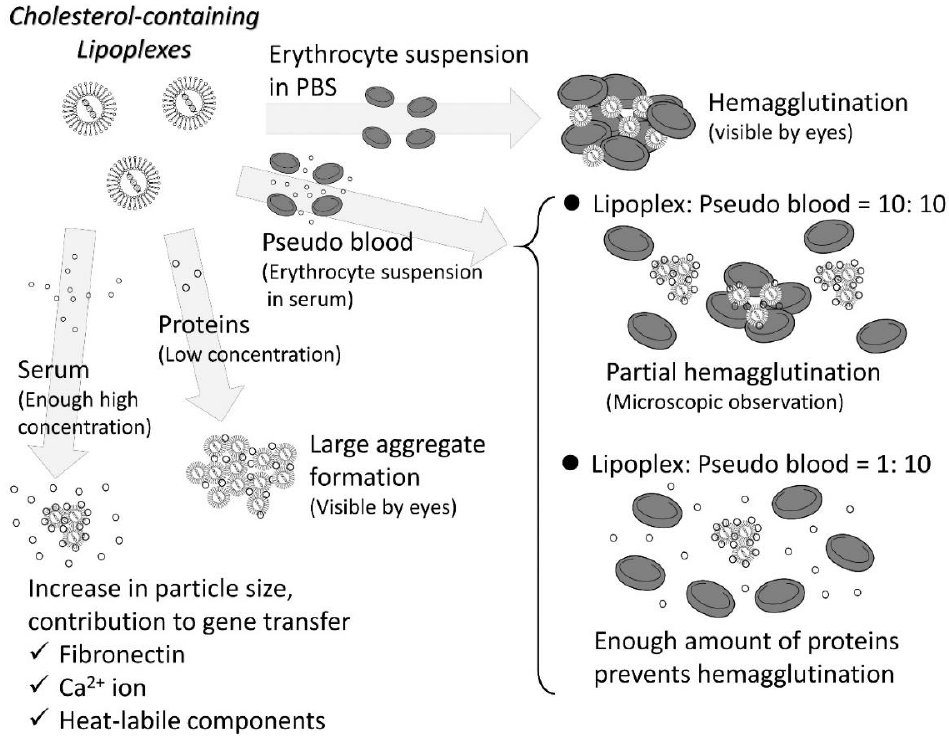
Figure 3. The role of blood components on hemagglutination, formation of large aggregates and size increase of cholesterol-containing lipoplexes, illustrated based on references [71,72].